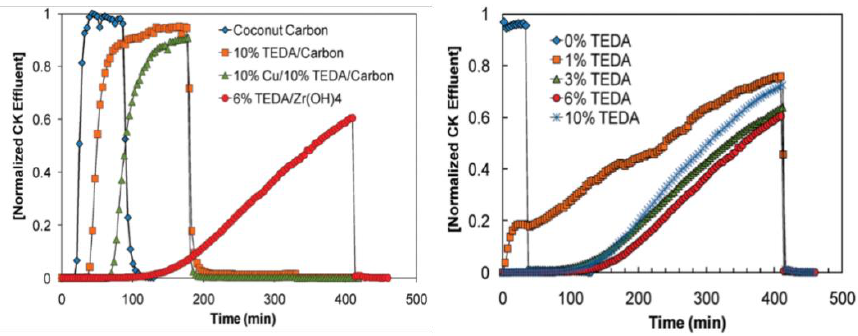
Figure 2. Penetration curves of CNCl on different protective materials [36].